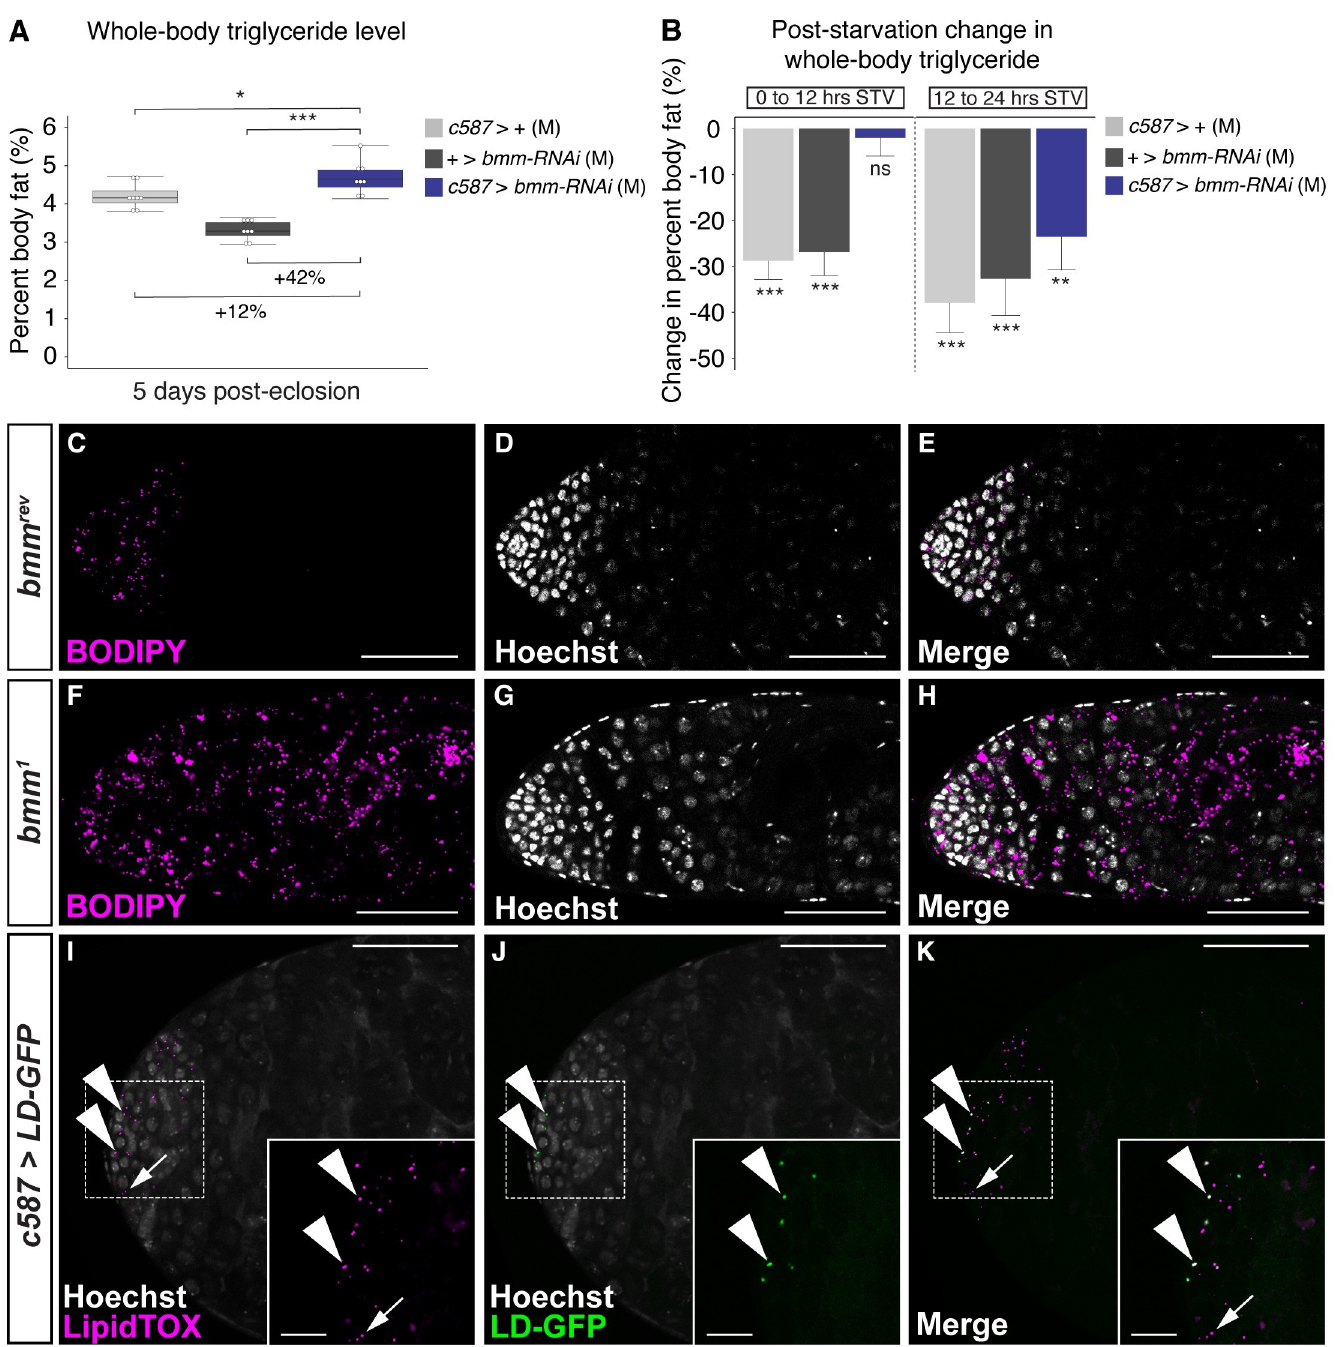
Fig 5. A role for bmm function in the somatic cells of the gonad in the regulation of whole-body triglyceride storage and breakdown in males. (A) Whole-body triglyceride storage in males overexpressing the UAS-bmm-RNAi transgene in the somatic cells of the male gonad ( c587 > UAS-bmm-RNAi ) was significantly higher than in control males ( c587 > + and + > UAS-bmm-RNAi ) ( p = 0.027 and 2 × 10 − 7 , respectively; one-way ANOVA followed by Tukey HSD test). (B) Whole-body triglyceride levels in c587 > + and + > UAS-bmm-RNAi control males showed a significant decrease between 0 and 12 hours STV (1 × 10 − 7 and 1.1 × 10 − 6 , respectively; one-way ANOVA followed by Tukey HSD test), whereas triglyceride levels were not significantly different between 0 and 12 hours STV in c587 > UAS-bmm-RNAi males ( p = 0.997; one-way ANOVA followed by Tukey HSD test). (C–H) We detected lipid droplets in testes dissected from 0-day-old bmm 1 and bmm rev virgin male flies using BODIPY, a neutral lipid stain. Dissected testis from 0-day-old virgin bmm 1 mutant males (F–H) show a dramatic increase in lipid droplets compared with control bmm rev males (C–E). (I–K) Using an LD-GFP, we found that a subset of the LipidTOX-positive lipid droplets in the testis (arrowheads) represent droplets in the somatic cells of the gonad. Non-GFP-positive droplets (arrow) likely represent lipid droplets in the germline, another cell type in the testis. Scale bars = 50 μ m, except for inset images for